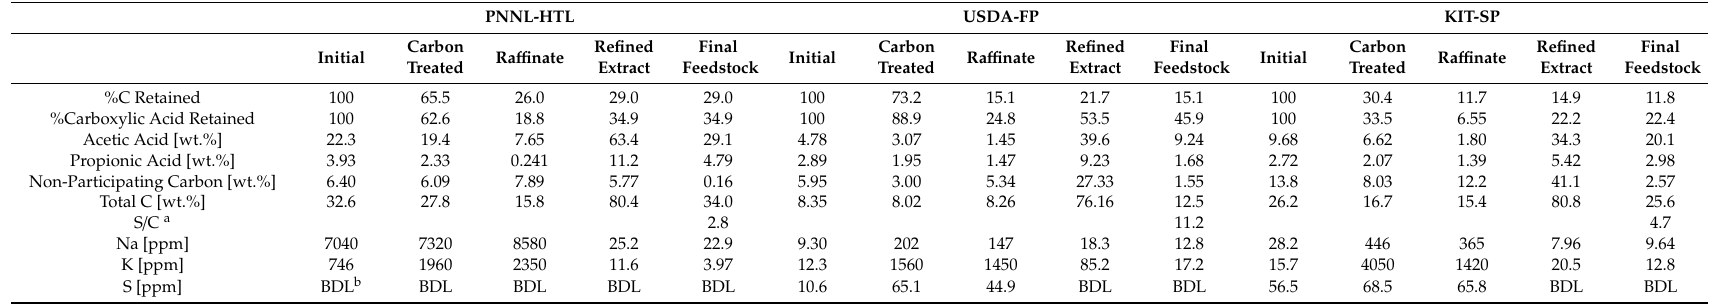
Table 1. Summary of stream composition at the di ff erent stages of the clean-up process. PNNL-HTL is derived from corn stover, processed using hydrothermal liquefaction (HTL) and originally published elsewhere [13]. USDA-FP is derived from horse litter, processed using fast pyrolysis (FP). KIT-SP is derived from beech wood chips, processed using intermediate screw pyrolysis (SP). More information about the composition can be found in the Supporting